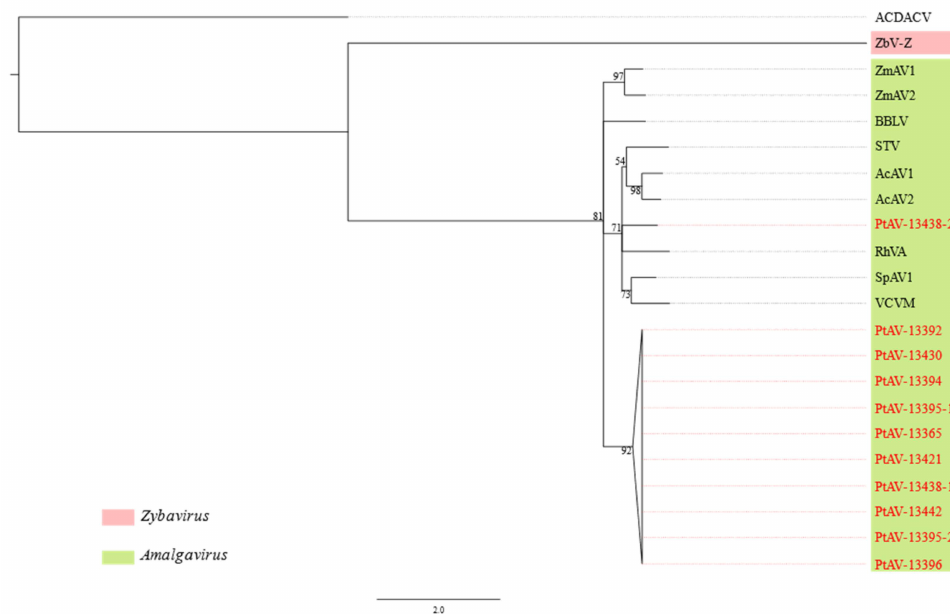
Figure 5. Maximum likelihood reconstruction of the phylogeny of amalgaviruses based on the RNA dependent RNA polymerase gene. The acronyms in red font correspond to the viruses discovered in this study (Table 1) and the other virus acronyms are defined in Table S5. The numbers next to the branches are non-parametric bootstrap values based on 1000 replicates. The nucleotide substitution model used for the phylogenetic tree is listed in Table